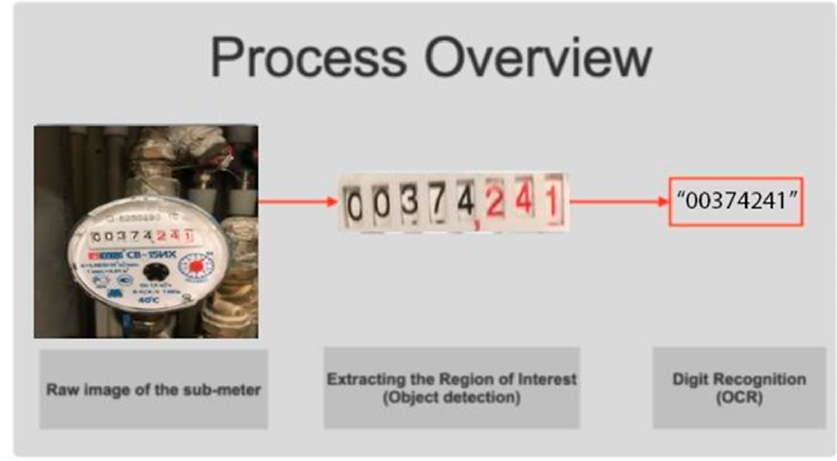
Figure 11. Process overview.